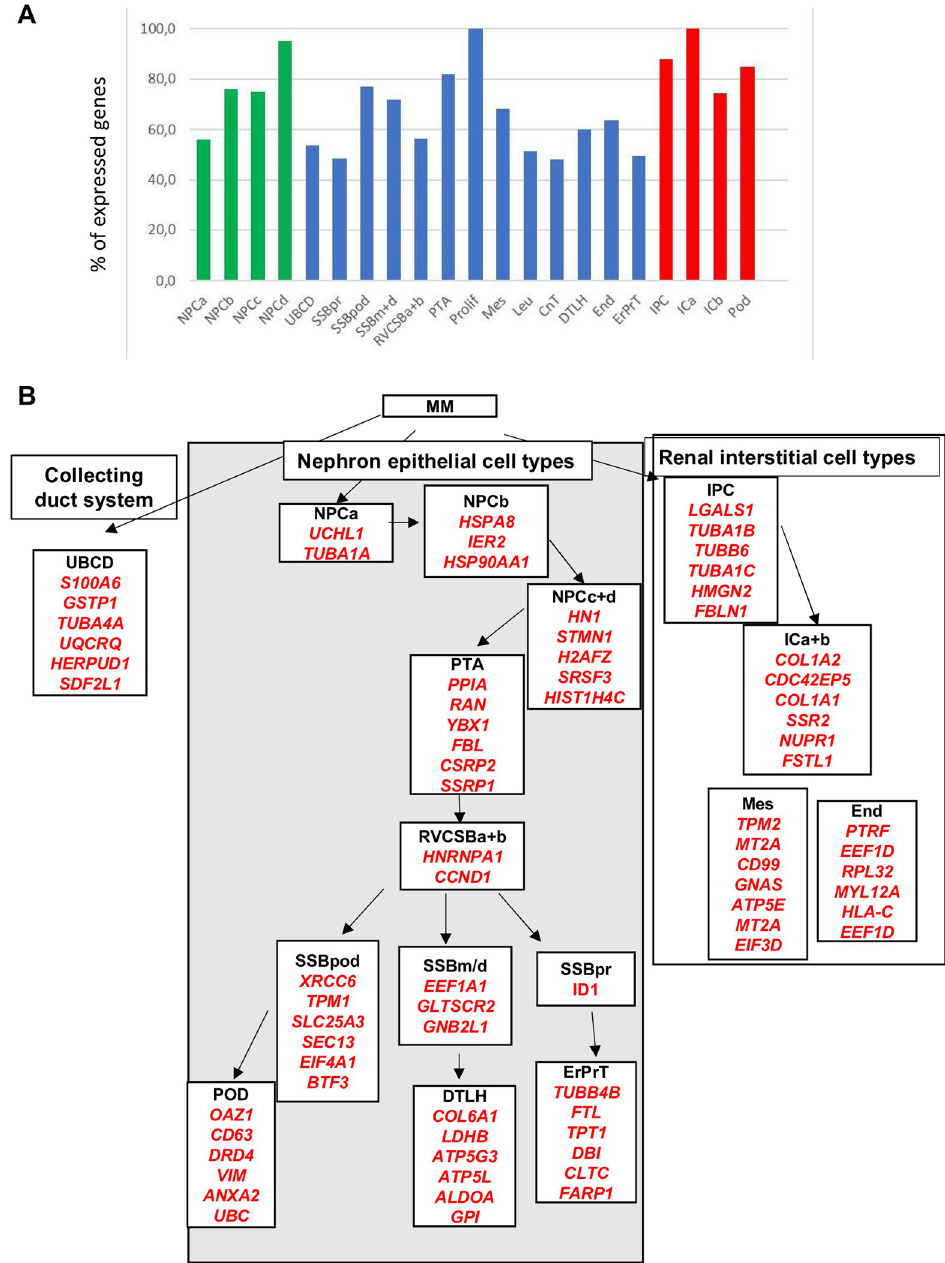
Fig 6. Analysis of genes expressed in the Wilms cells from the Hochane marker set candidates. A ) The percentage of genes expressed in each cluster is shown. B) Genes in each cluster from the three linages that are expressed > 50 000 are shown. Ribosomal genes were omitted. No genes in the CnT cluster were expressed above 50